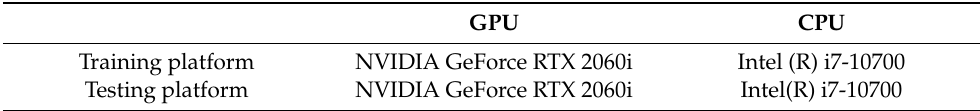
Table 3. Hardware parameters used to train and test the network.